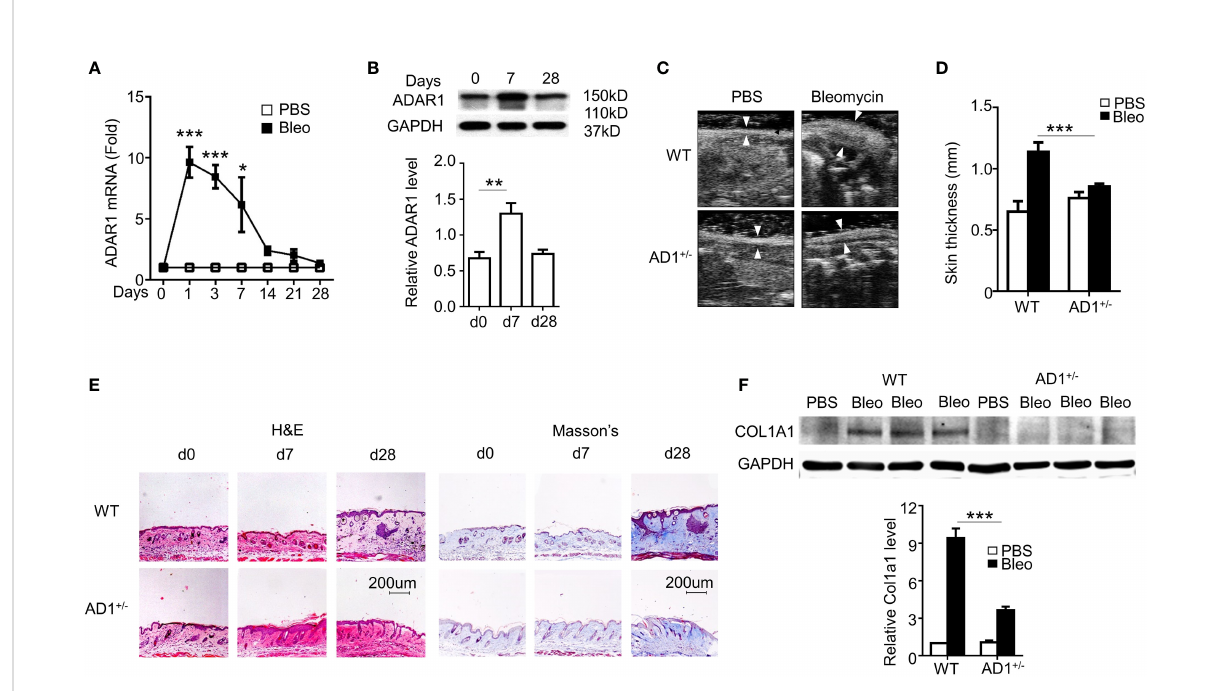
FIGURE 1 ADAR1 was essential for the pathogenesis of systemic sclerosis (SSc). (A, B) Mice were injected s.c. with bleomycin (Bleo: 0.02U) for the times indicated. ADAR1 mRNA (A) and protein (B) expression in skin were detected by qPCR and Western blotting, respectively. (B) ADAR1 protein levels were quanti fi ed by normalizing to GAPDH (n = 6). *P<0.05, **P<0.01, ***P<0.001 vs PBS-treated group for each isoform. 1-way ANOVA was used for comparison among groups. (C) ADAR1 heterozygous deletion (AD1 +/- ) attenuated bleomycin-induced skin fi brosis compared